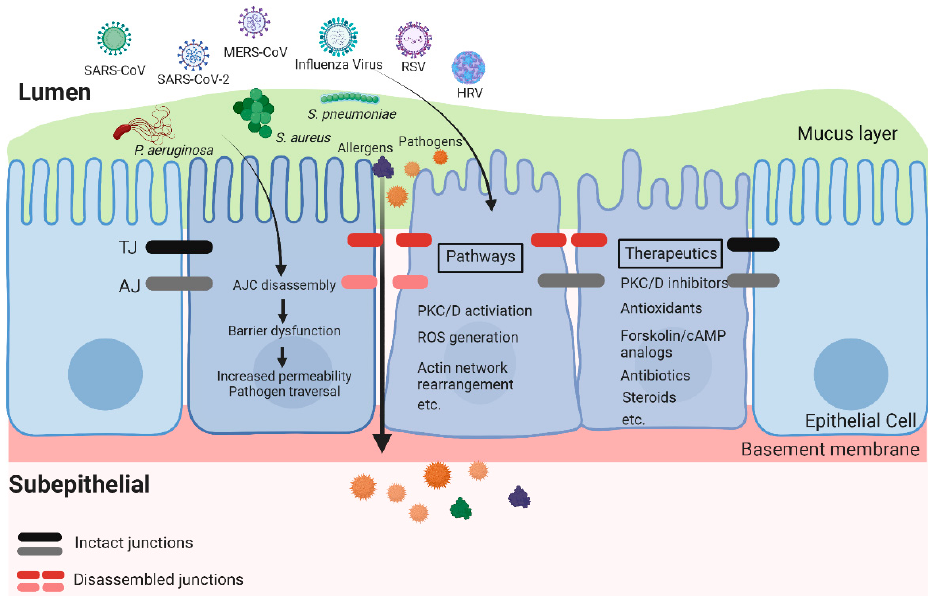
Figure 2. Disrupted epithelial barrier induced by invading microorganisms. Bacterial and viral infection can cause AJC disassembly and barrier disruption, the consequent increase in epithelial permeability will allow or exacerbate secondary invasions of allergens and pathogens into the subepithelial space. Multiple molecular pathways have been implicated in mediating or contributing to pathogen-induced AJC disassembly. Some examples are protein kinase C/D (PKC/D) activation, reactive oxygen species (ROS) generation, and rearrangement of the F-actin cytoskeleton. Therapeutics such as agonists and antagonists have been investigated and/or proposed to restore the epithelial barrier function caused in infected epithelial cells. Refer to Table 1; Table 2 for detailed information about the critical pathways and potential therapeutics. cAMP, cyclic adenosine monophosphate; HRV, human rhinovirus; IAV, influenza A virus; MERS-CoV, Middle East respiratory syndrome coronavirus; RSV, respiratory syncytial virus; SARS-CoV, severe acute respiratory syndrome coronavirus; SARS-CoV-2, severe acute respiratory syndrome coronavirus-2. This image was created with BioRender.com.